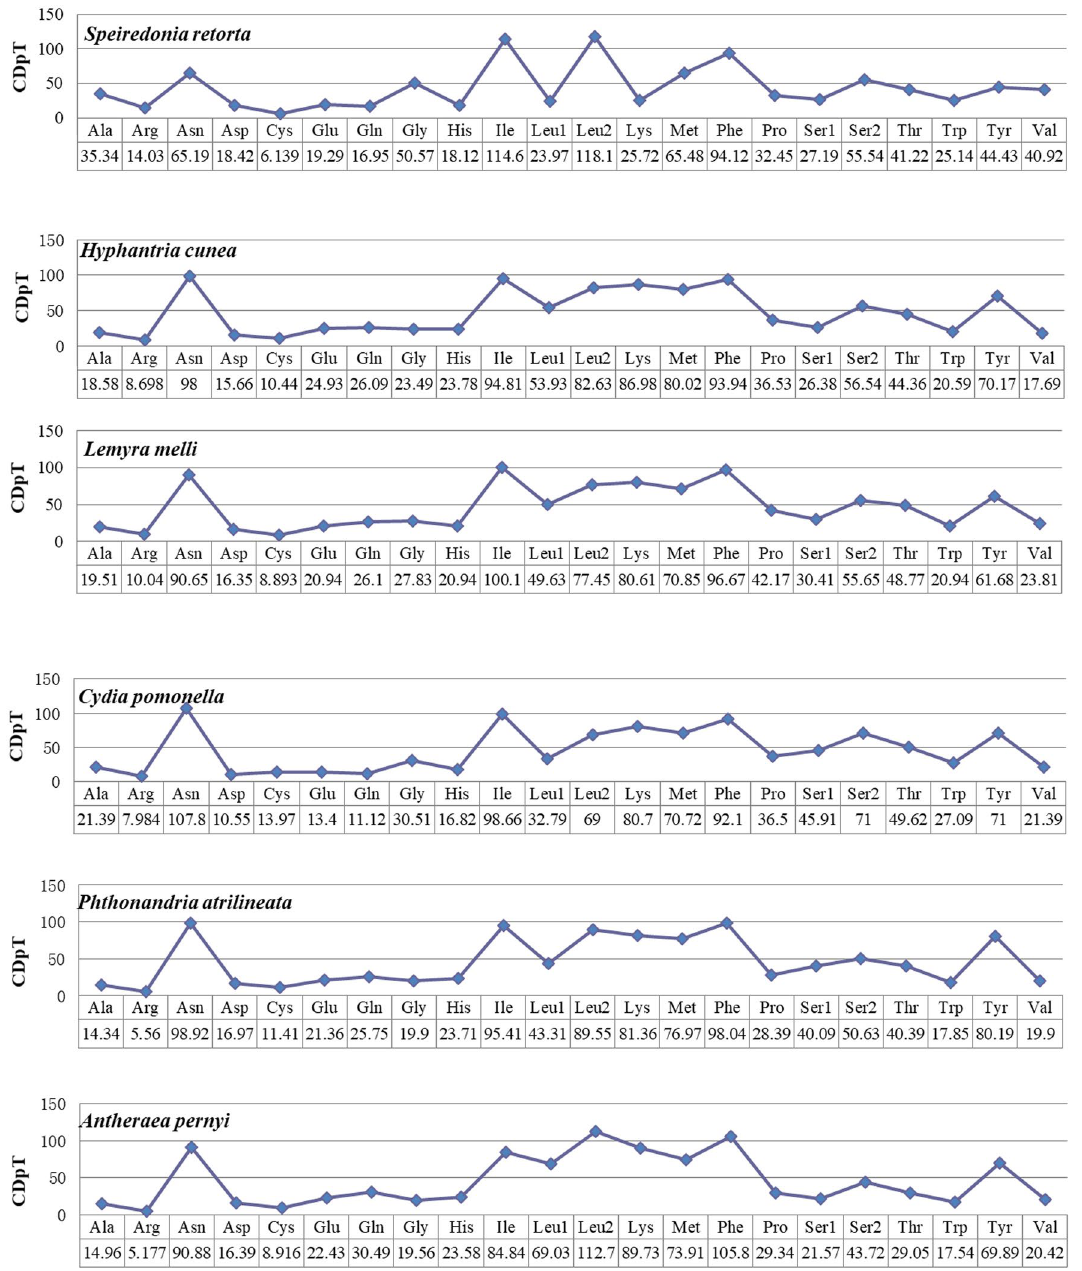
Figure 3. The distribution of codons among Lepidopteran species. CDspT codons per thousand